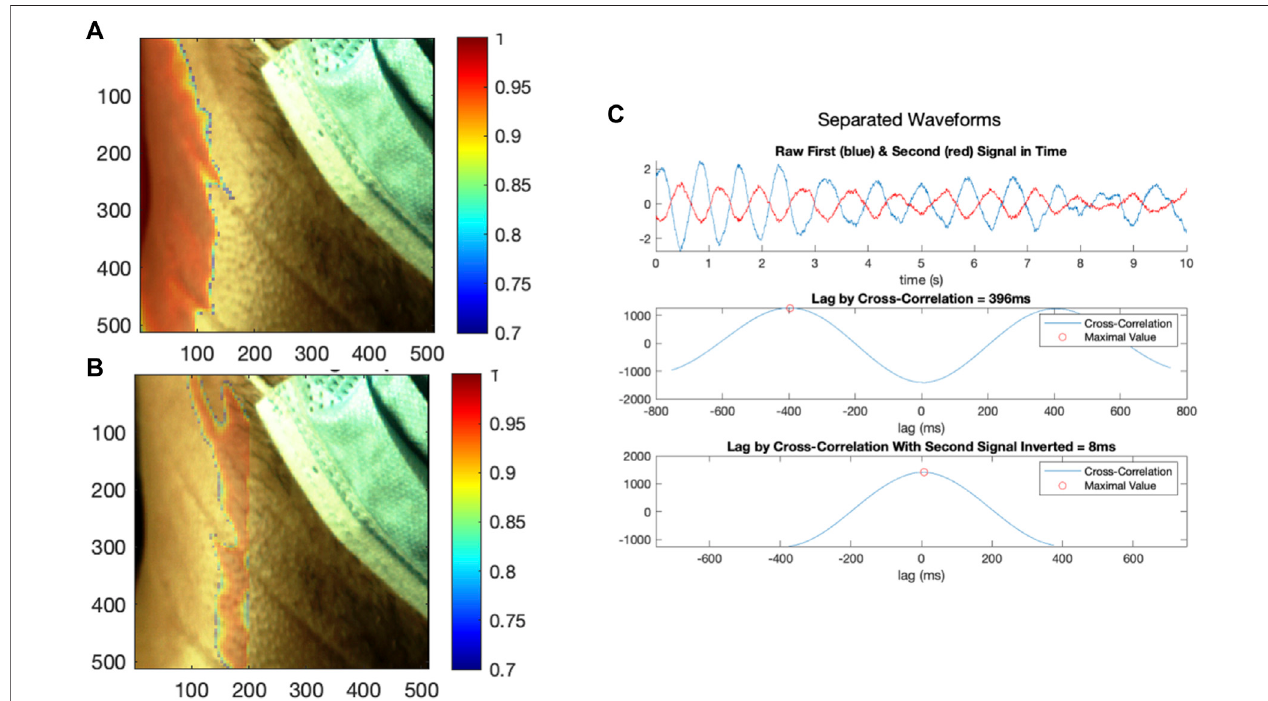
FIGURE6|(A) The fi rstregiongeneratinglocalSRVIsignalswithhighinternalcorrelation,withthecolourbarindicatingcorrelationofthelocalSRVIstotheaverage SRVI in that region, (B) the second region generating local SRVI signals with high internal correlation, with the colour bar indicating correlation of the local SRVIs to the averageSRVIinthatregion,and (C) theSRVIsignalsfromthe fi rstandsecondregionsplottedinthetimedomain,andanalyzedusingcross-correlation(asacquired,and with the second signal inverted).